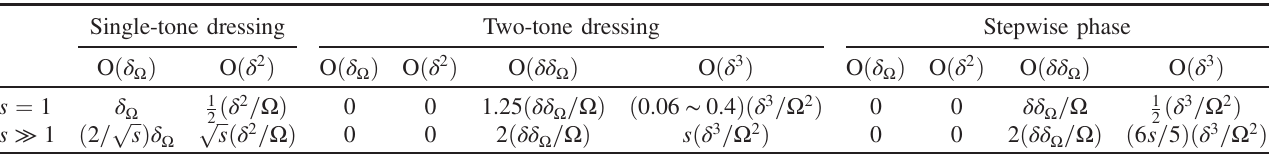
TABLE II. Higher-order corrections for the qubit transition frequency shifts: first-order in the drive noise [O ð δ Ω Þ ], second- and third- order in the inhomogeneous shift [O ð δ 2 Þ , O ð δ 3 Þ ], and their cross term [O ð δδ Ω Þ ]. Single-tone dressing Two-tone dressing Stepwise phase